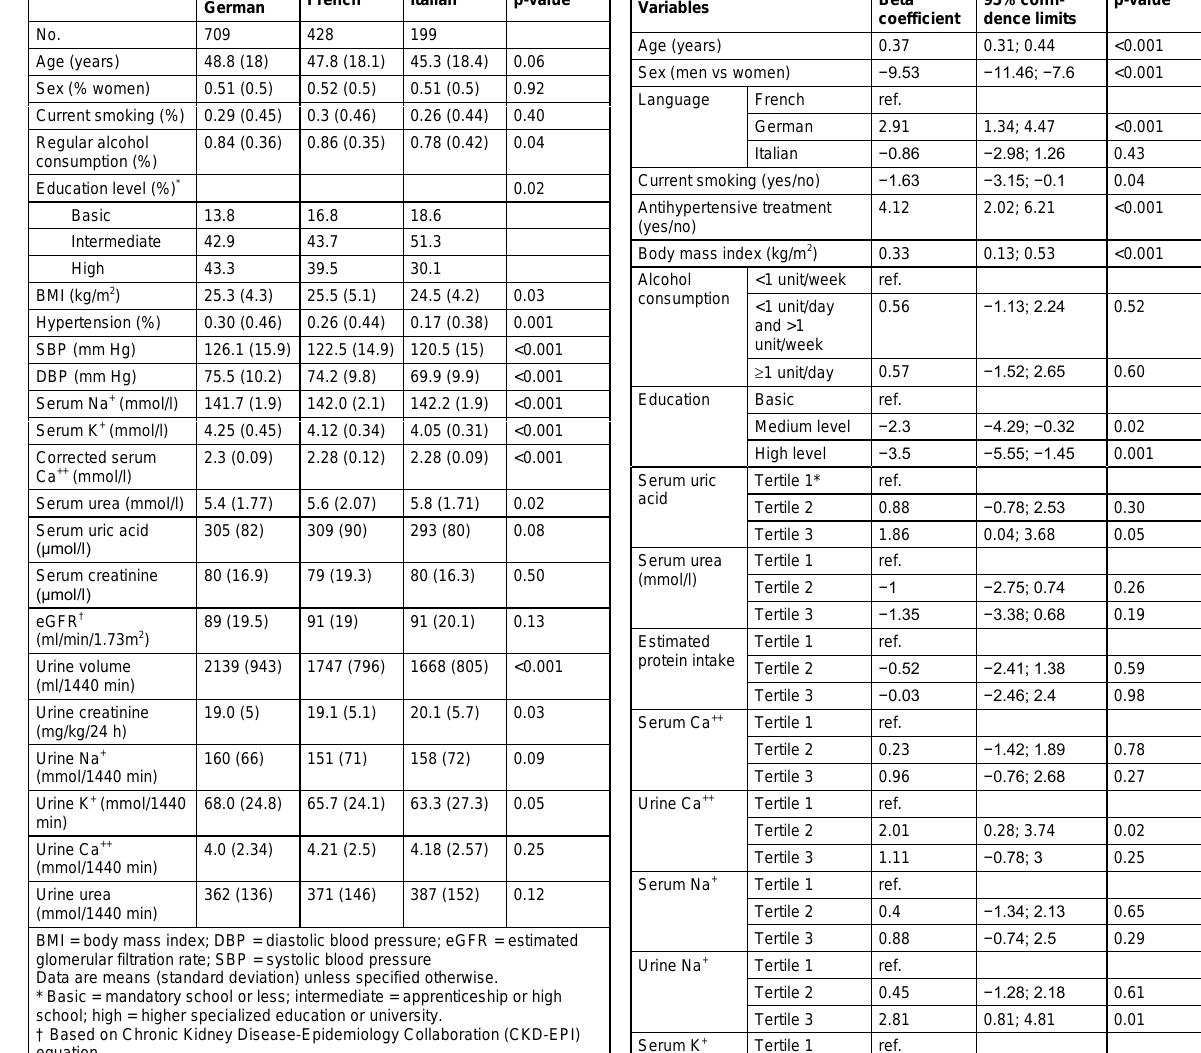
Table 2: Multiple linear regression for systolic blood pressure (n = 1336).